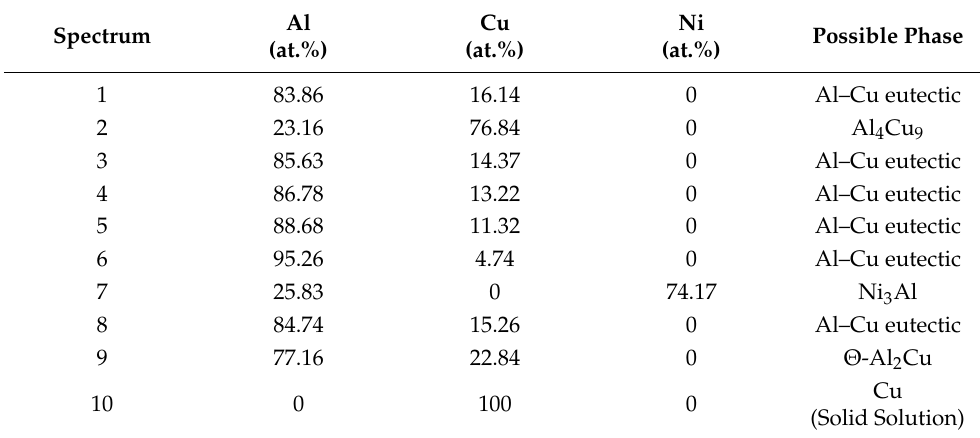
Table 4. Chemical composition of zones denoted in Figure 12.